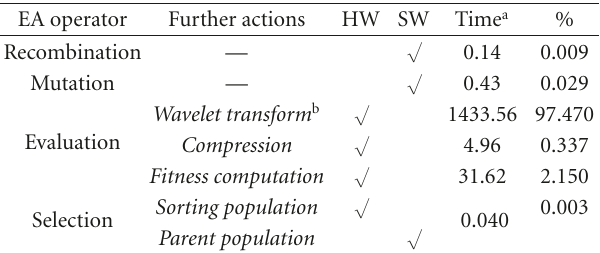
Table 15: Algorithm code